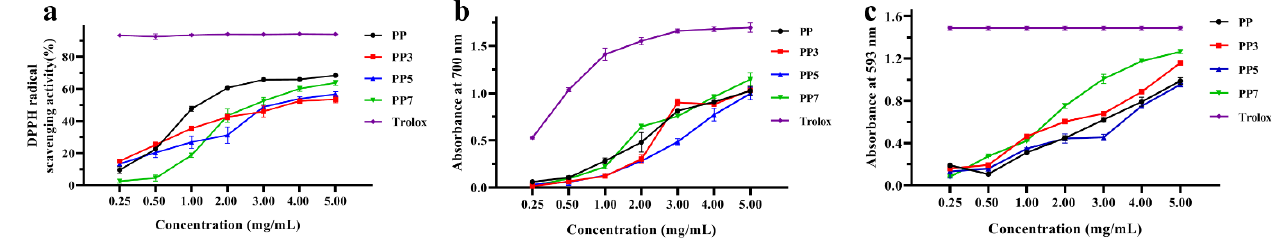
Figure 7. In vitro antioxidant activities of P. notoginseng polysaccharides at different concentrations. DPPH · scavenging abilities of PP, PP3, PP5, and PP7 ( a ), ferrous ion reduction force of PP, PP3, PP5, and PP7 ( b ), and total antioxidant capacities of PP, PP3, PP5, and PP7 ( c ).